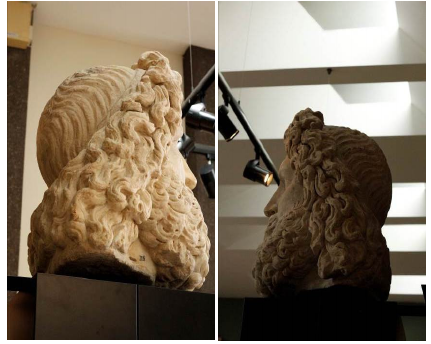
Figure 5 Sensors size for different camera models and brands.